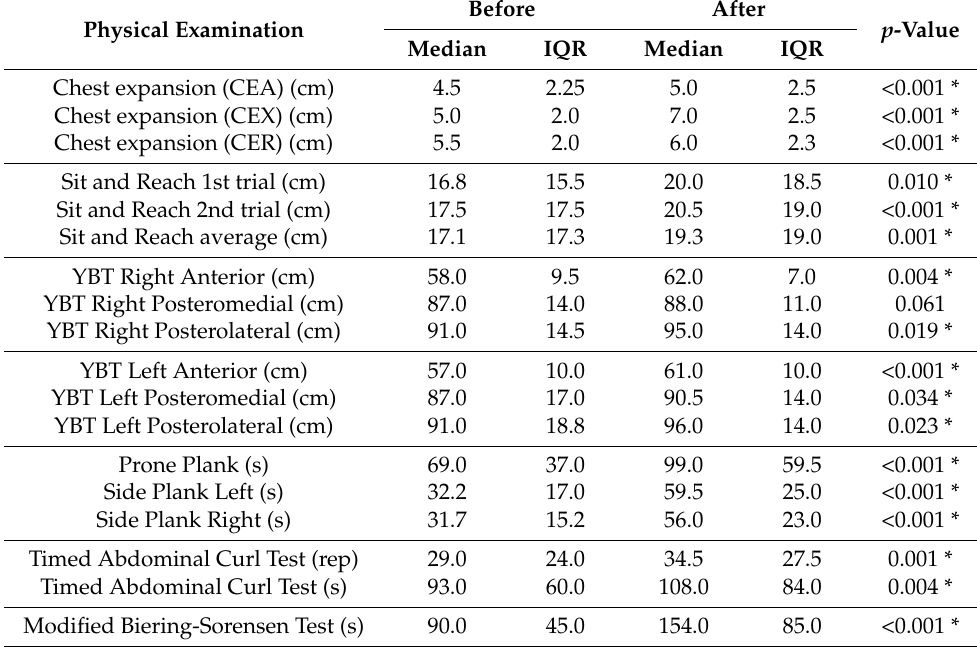
Table 8. Medians and interquartile ranges (IQRs) of parameters measured before and after the intervention ( n =